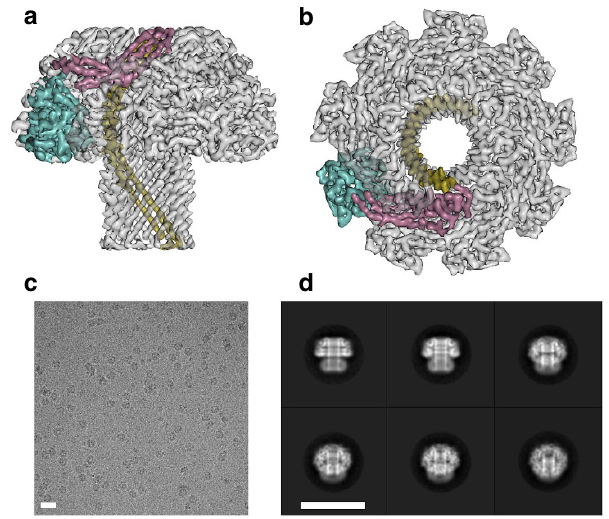
Figure 1 | Cryo-EM reconstruction of the lysenin pore. Surface representation of the sharpened 3.1Å map of lysenin shown from the side ( a ) and extracellular views ( b ). Side chain densities are clearly visible on the b -barrel pore. The three domains of a lysenin subunit are indicated: b -hairpin domain (olive), cap domain (pink) and receptor-binding domain (cyan). Representative cryo-electron micrograph of lysenin complexes on graphene oxide ( c ) taken at (cid:2) 2.3 m m defocus on an FEI Titan Krios with a Gatan K2 Summit detector. Characteristic 2D class averages of the lysenin oligomer ( d ). Scale bars,